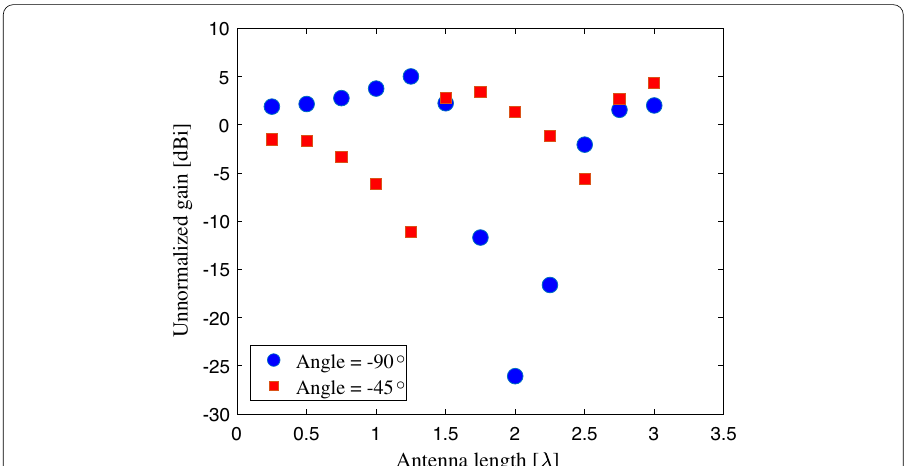
Fig. 10 Gain. Unnormalized gain of a dipole antenna with reconfigurable length. For a 2 (cid:31) antenna, there is a 27.4‑dB difference in gain between the